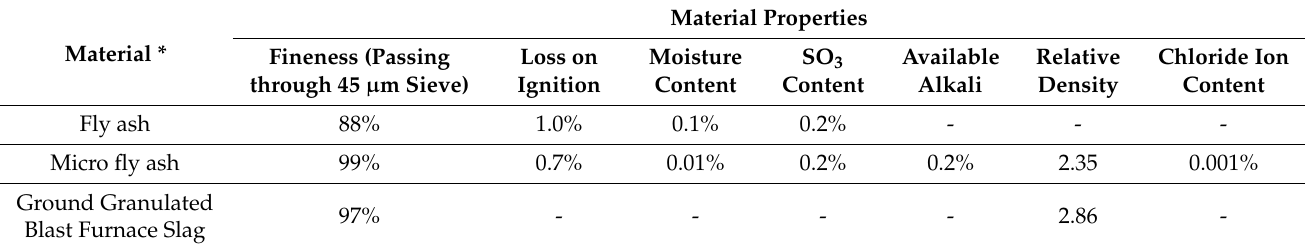
Table 1. Material properties of binder materials [3].